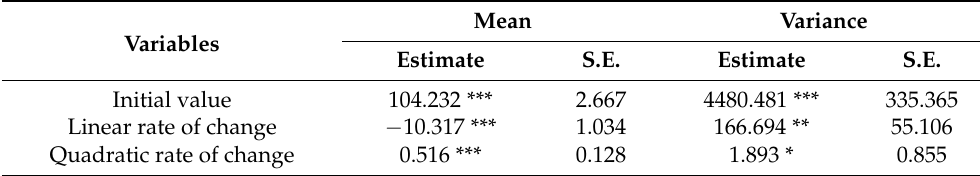
Table 3. Mean and Variance of initial score and rate of change of Unconditional Model.